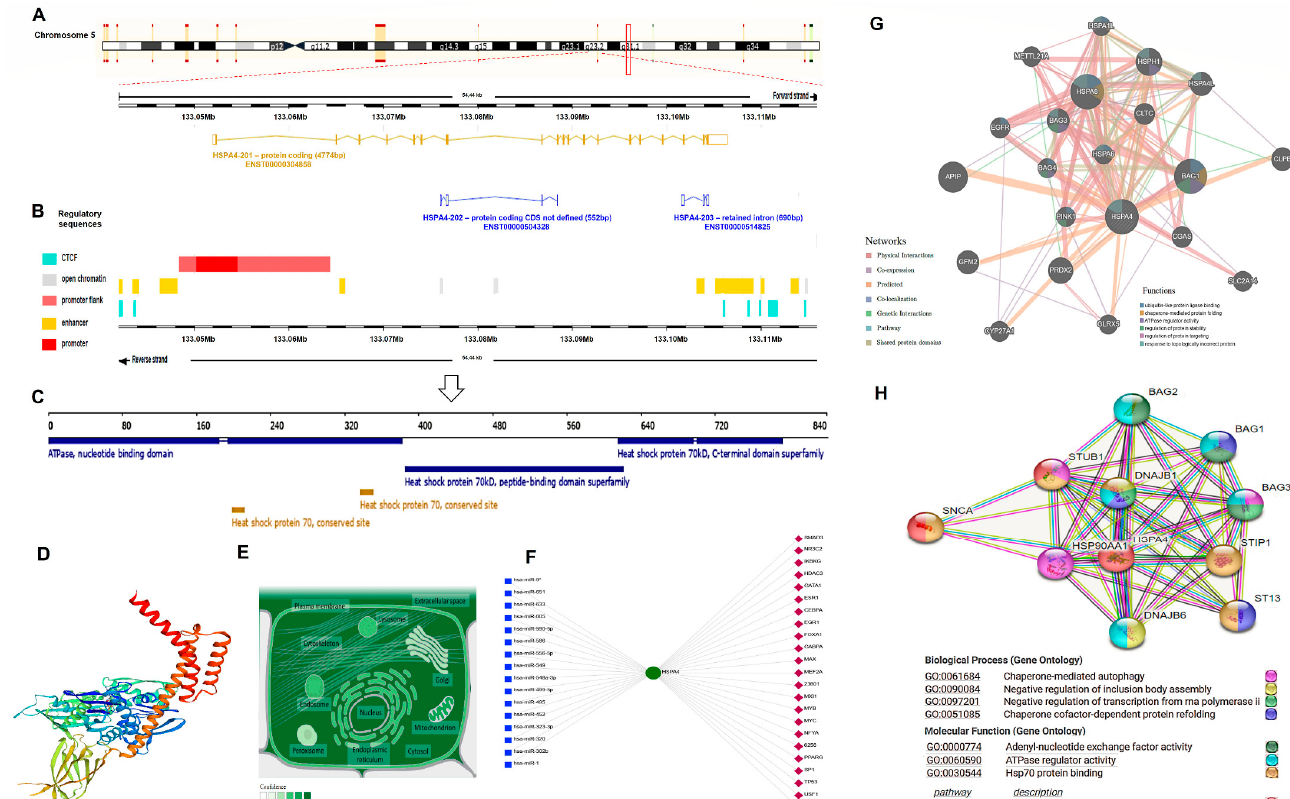
Figure 6. Structural and functional analysis of HSP70 (gene name: HSPA4 ). ( A ) The chromosomal location of the studied gene and the related transcripts. ( B ) The cis (e.g., promoter and enhancer sequences) and trans (e.g., CCCTC-binding factor; CTCF) acting regulatory factors. ( C ) The 840 amino acid HSP70-related protein product with the different domains and conserved sites. ( D ) The pre- dicted 3D structure of HSP70 generated by “SWISS-modelling”. ( E ) The subcellular localization of HSP70. The color degree is related to protein abundance. ( F ) The transcriptional factor (TF)-miRNA coregulatory interactions include 23 TFs (red diamonds) interacting with the specified gene and 16 microRNAs (blue squares) targeting HSP70 generated by “Network Analyst 3.0”, filtered by the type of tissue (kidney). ( G ) The “gene- gene interaction network” generated in GeneMania using homo sapiens HSPA4 as a driver gene. ( H ) The protein-protein interactions network with the top biological processes, molecular functions, and pathways created by the “STRING database”. Each interacting node with the hub HSP70 represents the top 10 predicted functional protein partners with a high level of confidence. The average node degree was 13.8, the average local clustering coefficient was 0.82, and the PPI enrichment p -value was <1.0 × 10 − 16